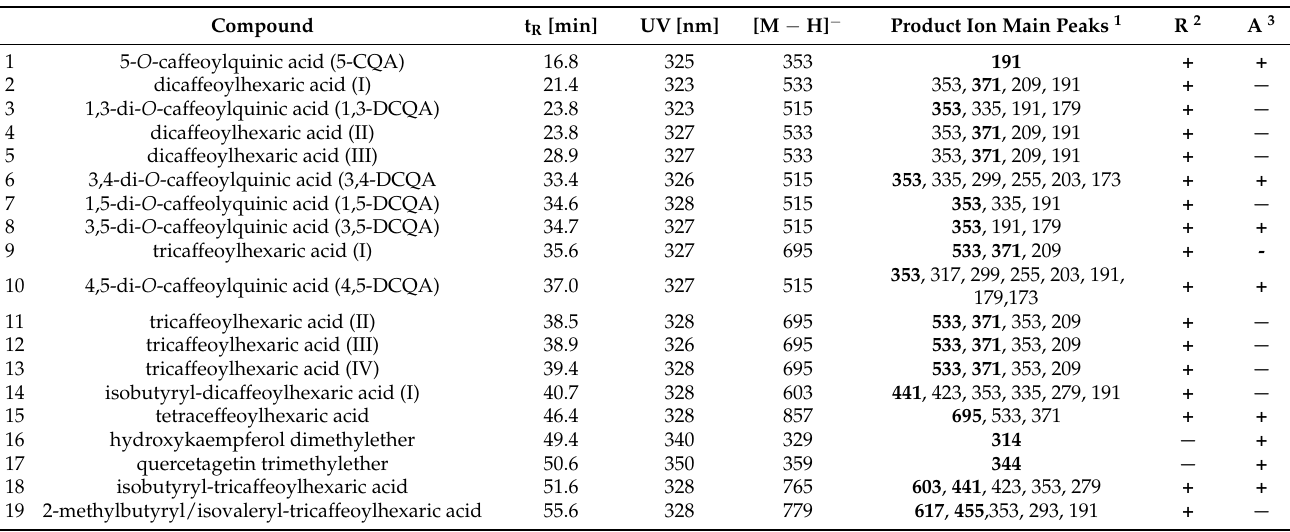
Table 1. Retention times, UV maxima and MS n data (in the negative ion mode) for the compounds present in Pulicaria inuloides